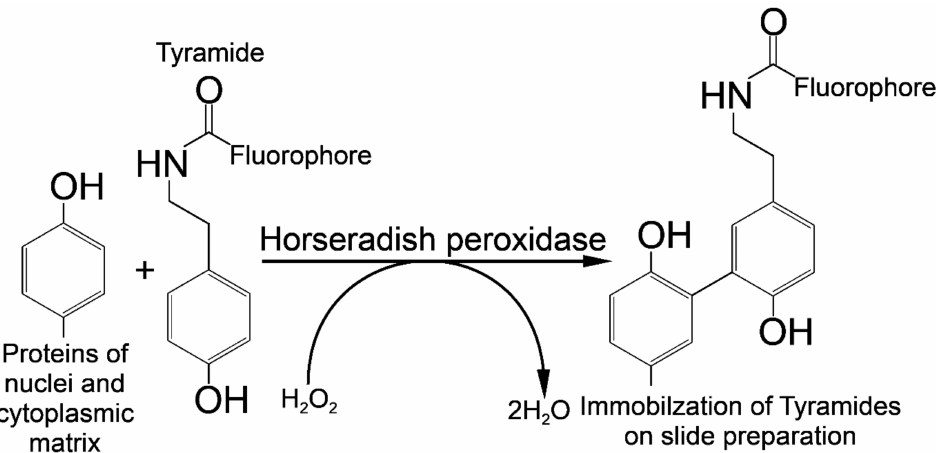
Figure 5. Horseradish peroxidase is a hydrogen peroxide (H 2 O 2 ) decomposing enzyme concomitant with the oxidation of phenolic substrate (tyramide) and reaction with electron-rich moieties of proteins of nuclear and cytoplasmic